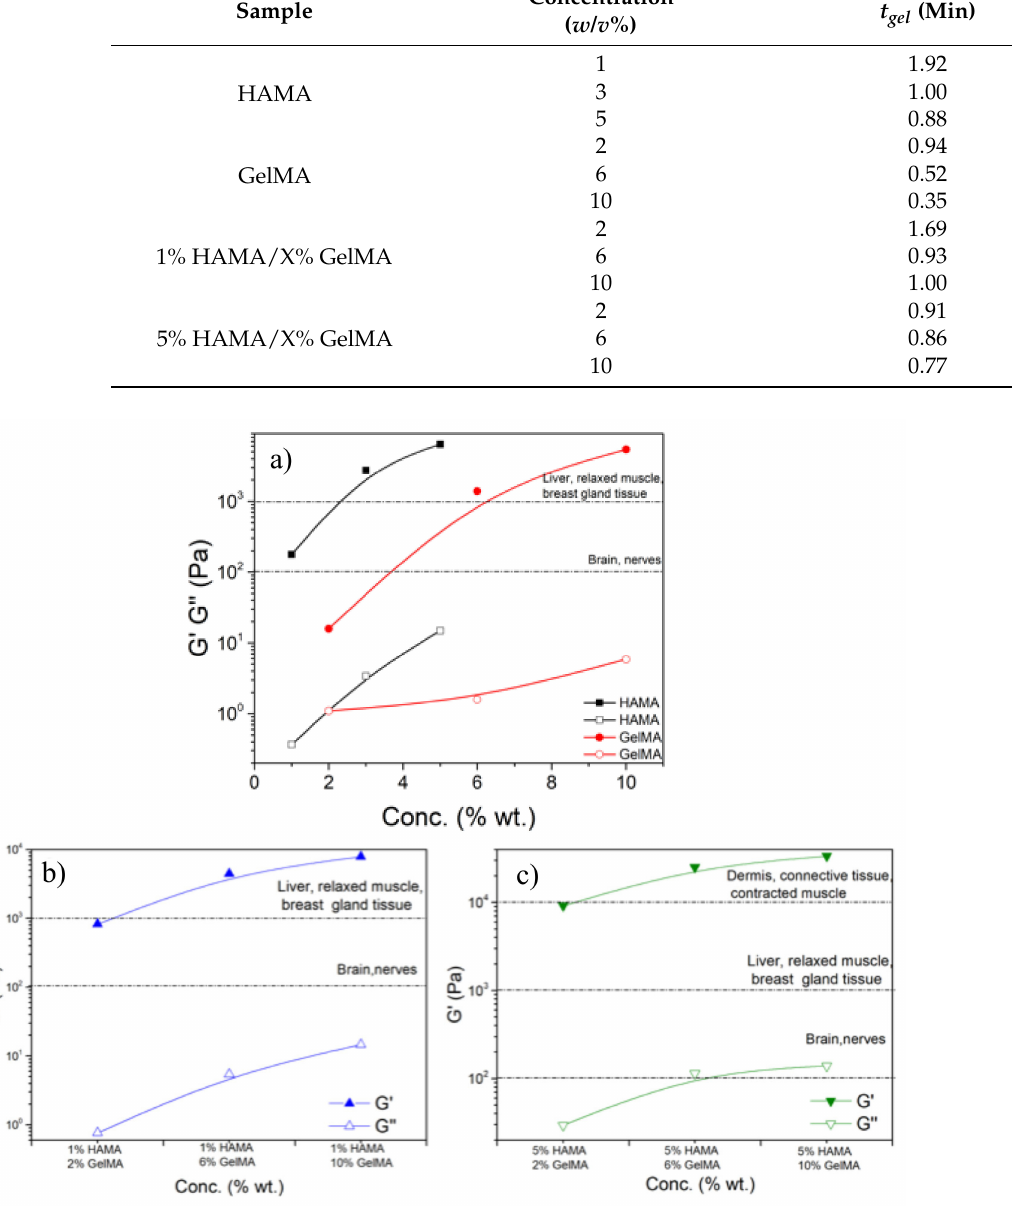
Figure A3. Storage and loss moduli as a function of HAMA and GelMA concentrations for pure ( a ) HAMA and GelMA and ( b , c ) hybrid hydrogels at 37 ◦ C and a frequency of 6.28 rad/s. Dashed lines represents the limits of the G (cid:48) values for use of the hydrogel as scaffolds for different types of tissues [5]. The continuous lines are to guide the